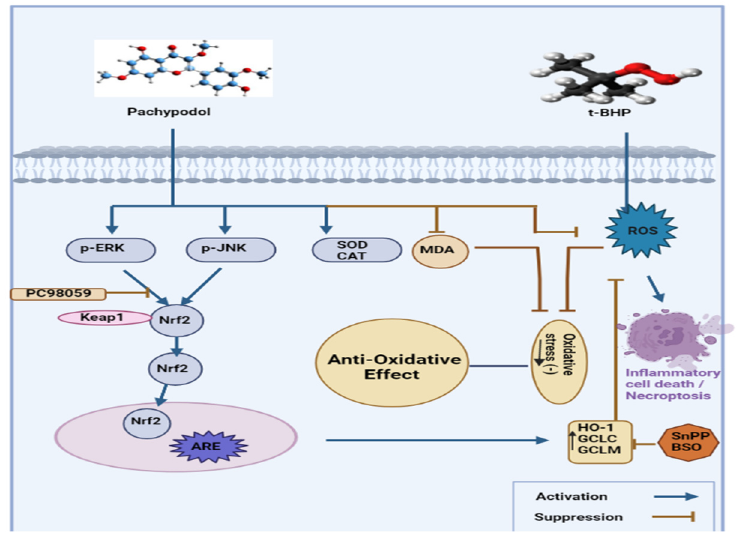
Figure 2. Anti-oxidative pathway activation by pachypodol.